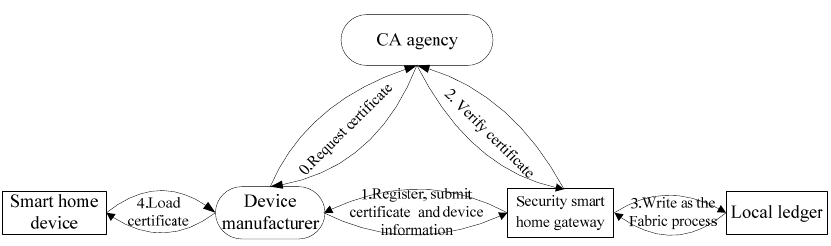
Figure 7. Registering of smart home device.